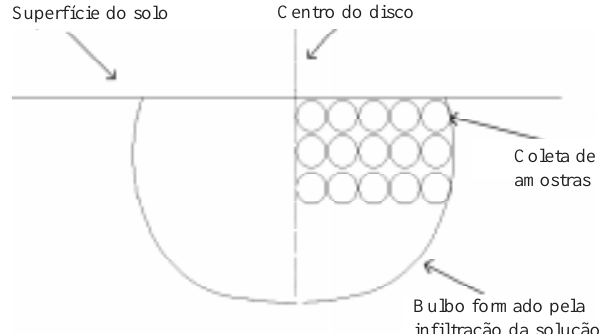
Figura 2. Esquema (visto de cima) de coleta de amostras de solo no campo, após o ensaio de infiltração.